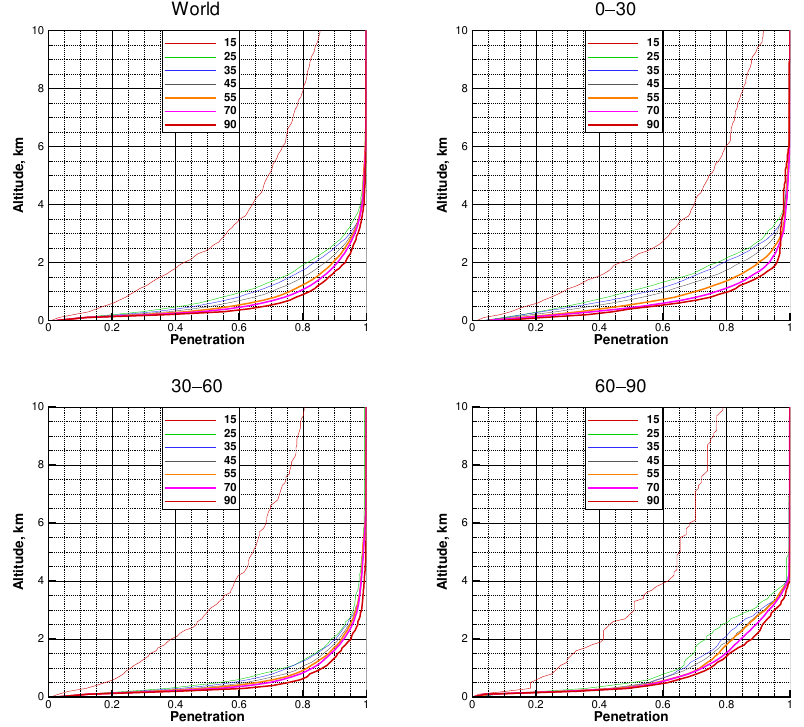
Figure 4. Similar to Figure 2. COSMIC,